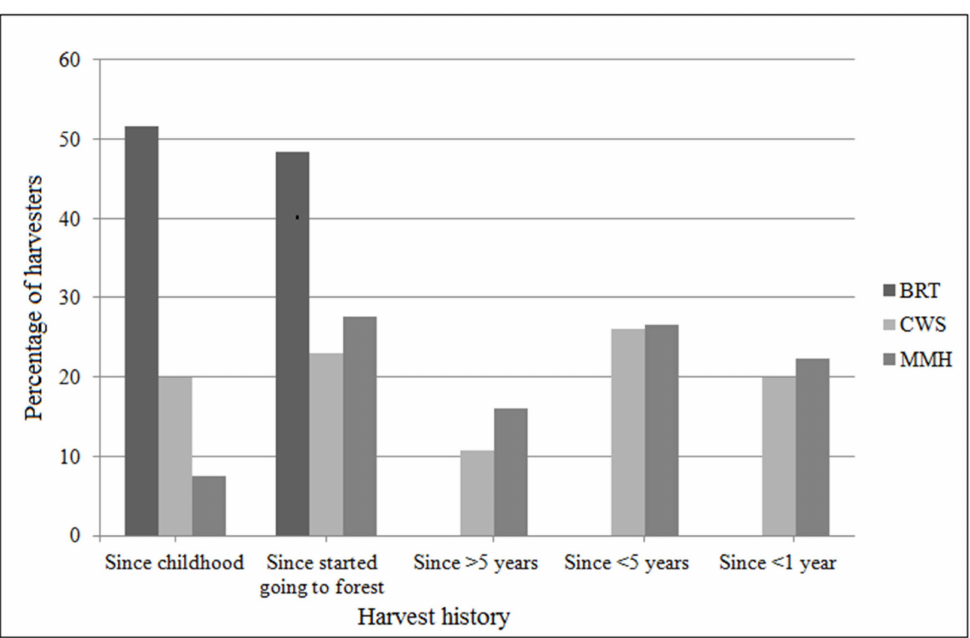
Figure 3. Length of time as a